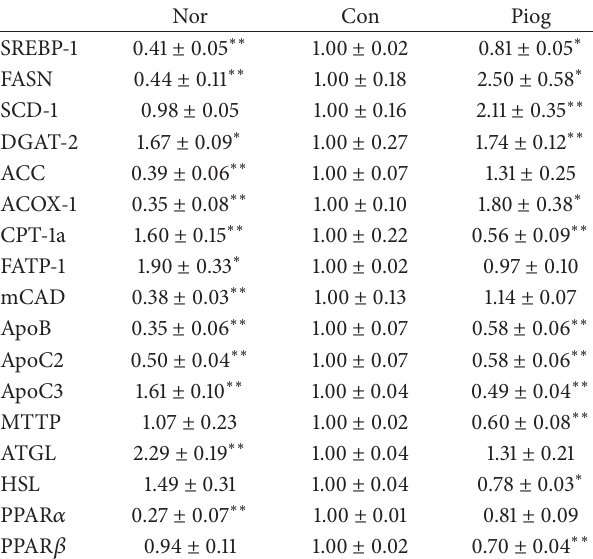
Table 1: Effects of pioglitazone on the expression of fatty acid metabolism related genes in the liver of KKAy